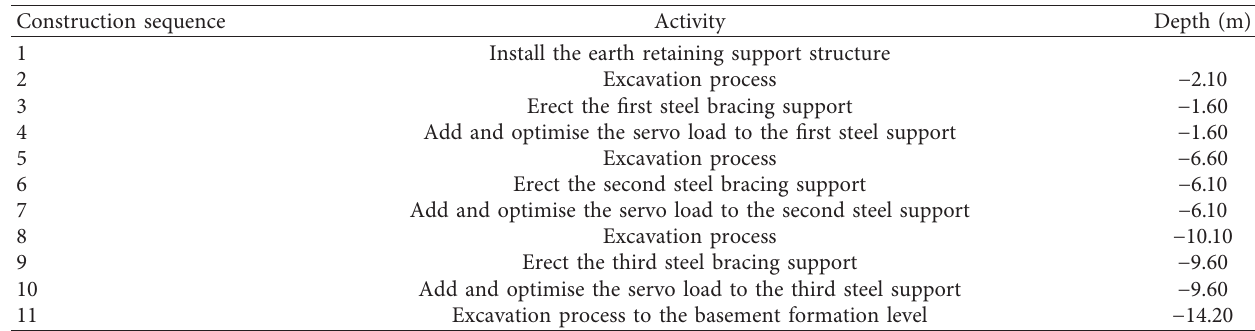
Figure 21: Triumph Unit building block basement excavation pit cross-sectional view. Table 6: Triumph Unit excavation field